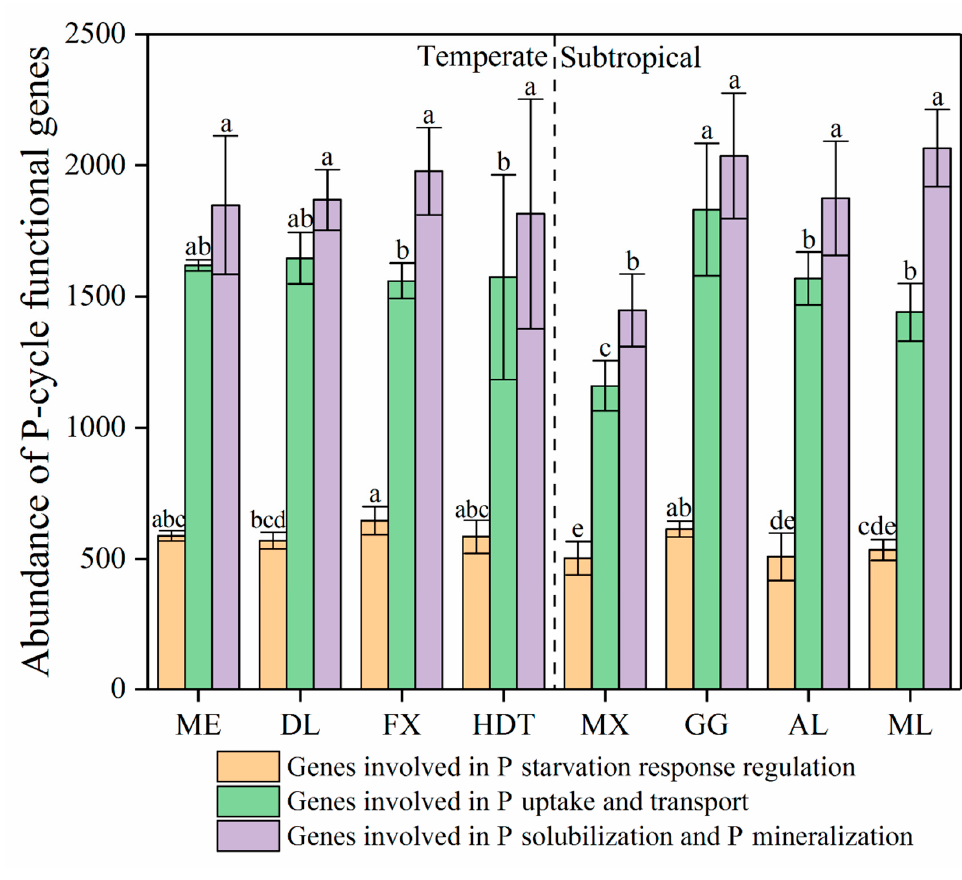
Figure 2. Variation in the abundance of P functional genes among the subtropical–temperate forest biomes in China. The 40 phosphorus functional genes were grouped into three main categories (P starvation response and regulation, P uptake and transport, P solubilization and mineralization) and the three categories of phosphorus genes varied in forests biomes. The abbreviations of sampling sites from north to south are as follows: ME, Maoer mountain; DL, Dongling mountain; FX, Fuxian; HDT Huoditang; MX, Maoxian; GG, Gongga mountain; AL, Ailao mountain; ML, Karst Mulan Station. Values presented are means ± SD (n = 3). Different letters above error bars indicate significant difference at p < 0.05 for the same gene category using LSD (L) and Duncan (D) tests. Table 1. The average abundance of phosphorus functional genes of Acidobacteria , Actinobacteria , Proteobacteria , and Verrucomicrobia between temperate and subtropical forest